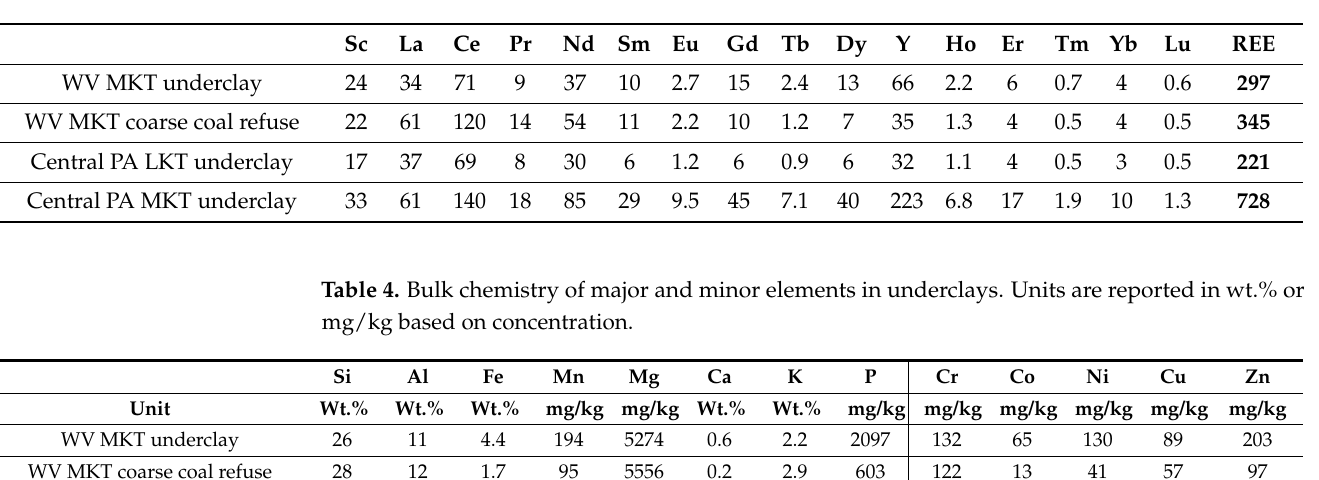
Table 3. Bulk chemistry of REEs in analyzed underclays. Units are reported in mg/kg.